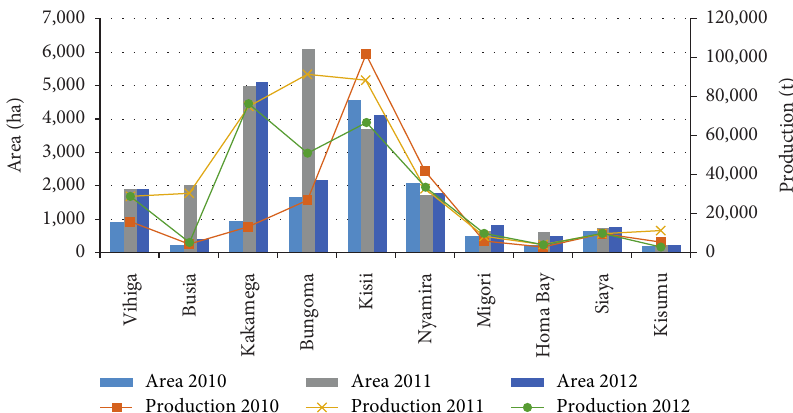
Figure 6: Banana area and production in western Kenya by county.